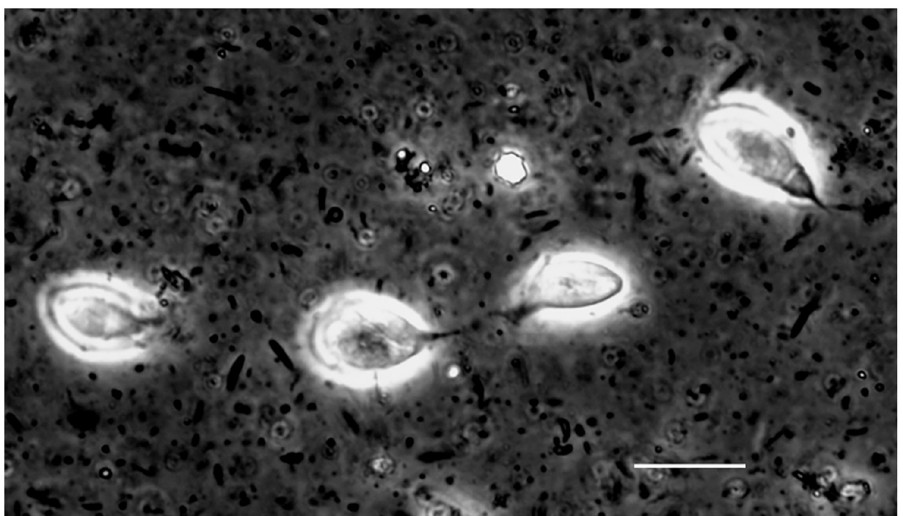
Fig 5. Photomicrograph of live Tritrichomonas flagellated protozoan in the cecal fluid of P . leucopus LL stock. Four organisms against the background of intestinal bacteria were visualized in the wet mount by differential interference microscopy. Bar, 10 μ